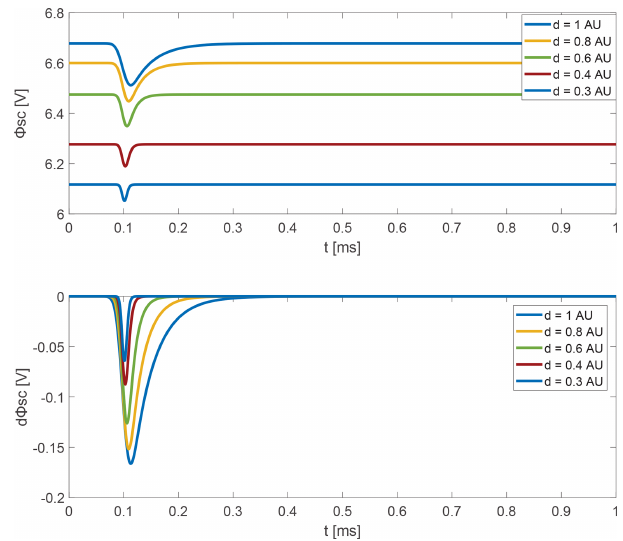
Figure 13. The estimated signals for impacts of 0.1µm particles with speed 100kms − 1 for spacecraft at different distance from the Sun. The charge production of the impact is assumed to be Q = 30pC. Estimate based on the Vaverka et al. (2017b)